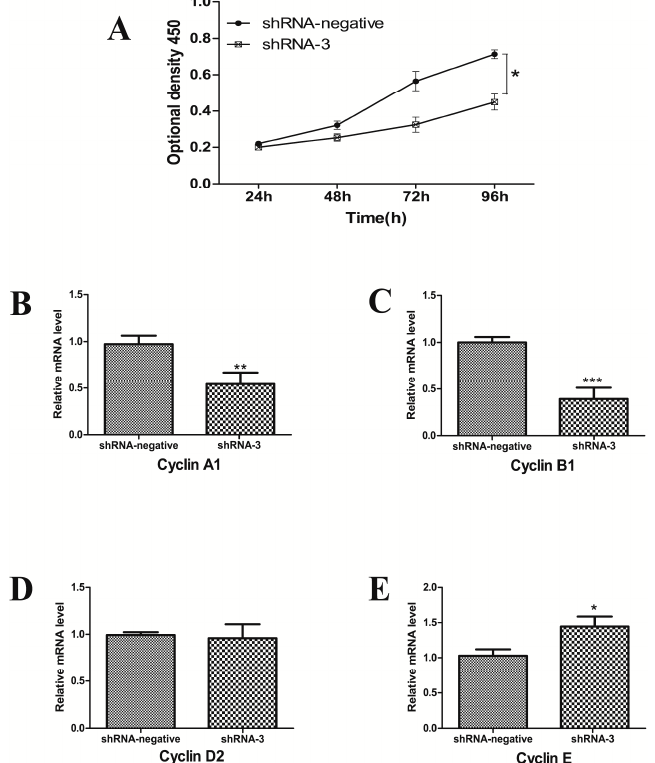
Figure 4. Effects of XBP1 inhibition on cell cycle and proliferation. ( A ) The GC proliferation was assessed using the CCK8 assay in the shRNA-3 and shRNA-negative groups; ( B – E ) The mRNA expression of genes (Cyclin A1, Cyclin B1, Cyclin D2, and Cyclin E) related to the cell cycle were detected by real-time PCR in mouse GCs after shRNA-3 and shRNA-negative treatment for 48 h. Data are shown as the mean ± SEM. Bars with asterisks represent a significant difference (* p < 0.05, ** p < 0.01, *** p <